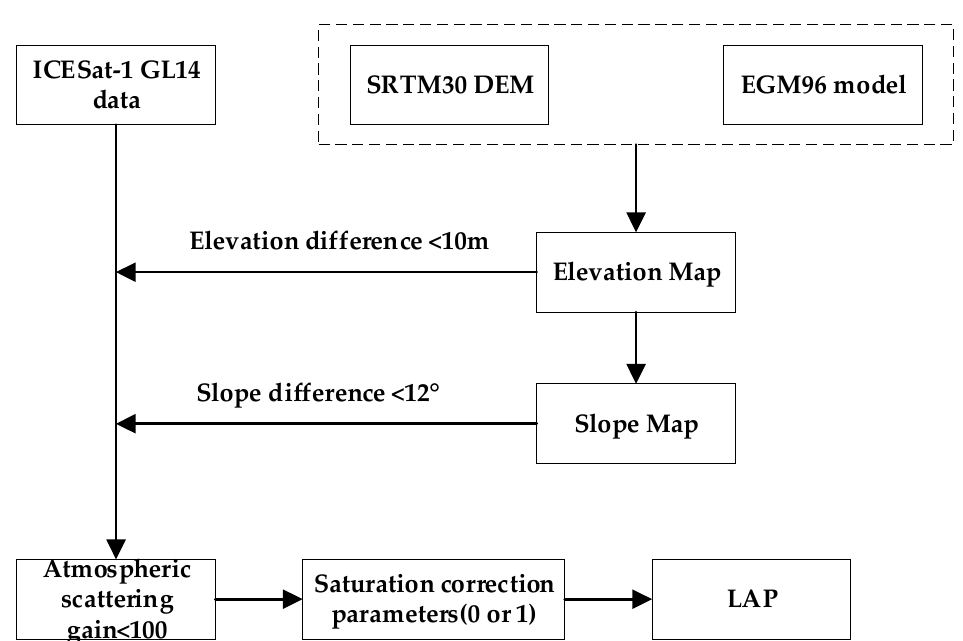
Figure 4. Geoscience Laser Altimeter System (GLAS) L14 Product laser altimetry points (LAPs) Selection Method.